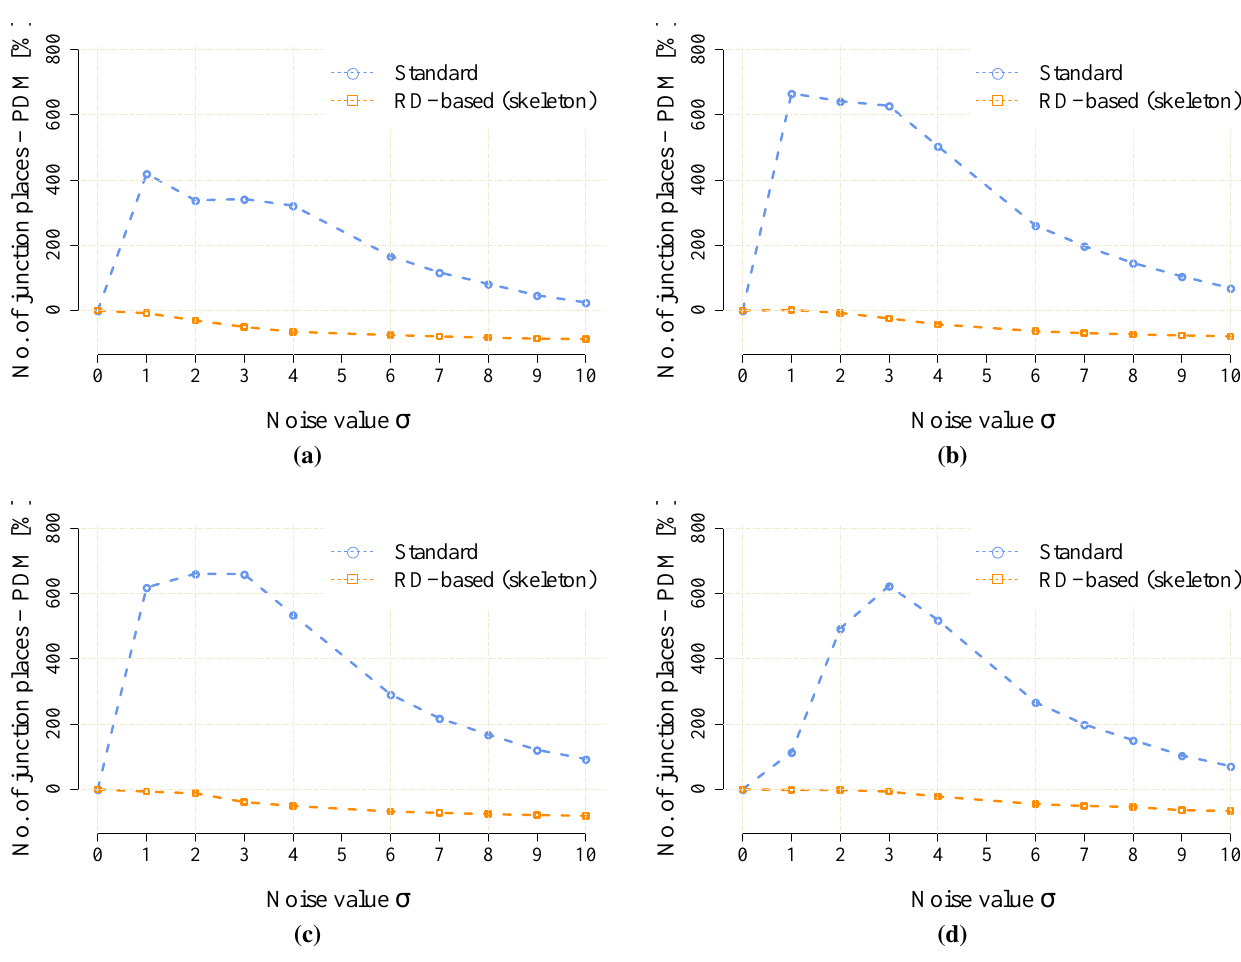
Figure 19. The noise sensitivity indicator JPDM Equation (3) in the scaled noisy maps of the jh environment. ( a ) jh , 768 × 863; ( b ) jh , 960 × 1079; ( c ) jh , 1088 × 1222; ( d ) jh , 1280 ×